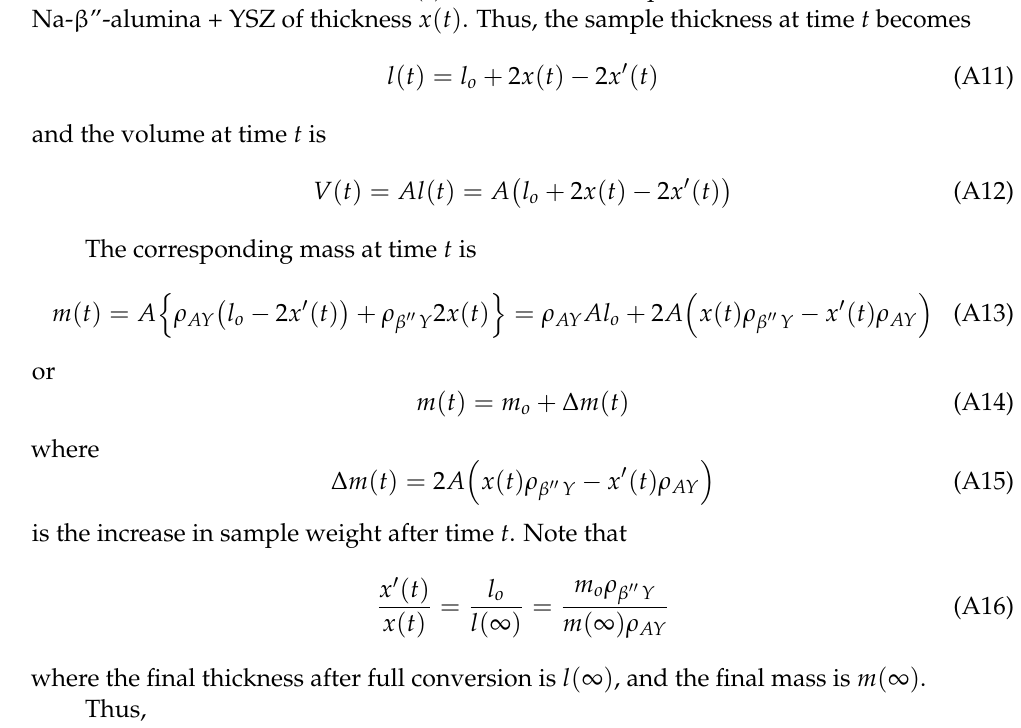
Figure A2. Schematics showing ( a ) a sintered α -alumina + YSZ sample before conversion and ( b ) after partial conversion. x (cid:48) ( t ) is the initial thickness of α -alumina + YSZ which converted into Na- β ”-alumina + YSZ of thickness x ( t ) , in a conversion time of t . After time t , the thickness x (cid:48) ( t ) of the initial sample on both surfaces converts